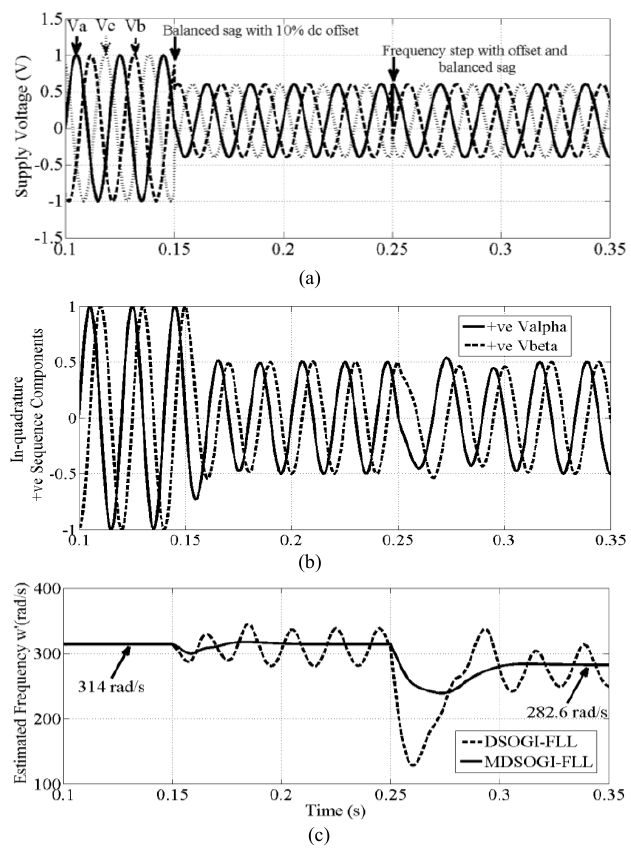
Fig. 5. Performance under balanced sag conditions: (a) Three-phase grid voltage signals (b)in-quadrature ( 𝑣 𝛼+ and𝑣 𝛽+ ) positive sequence components ( c ) Estimated frequency.